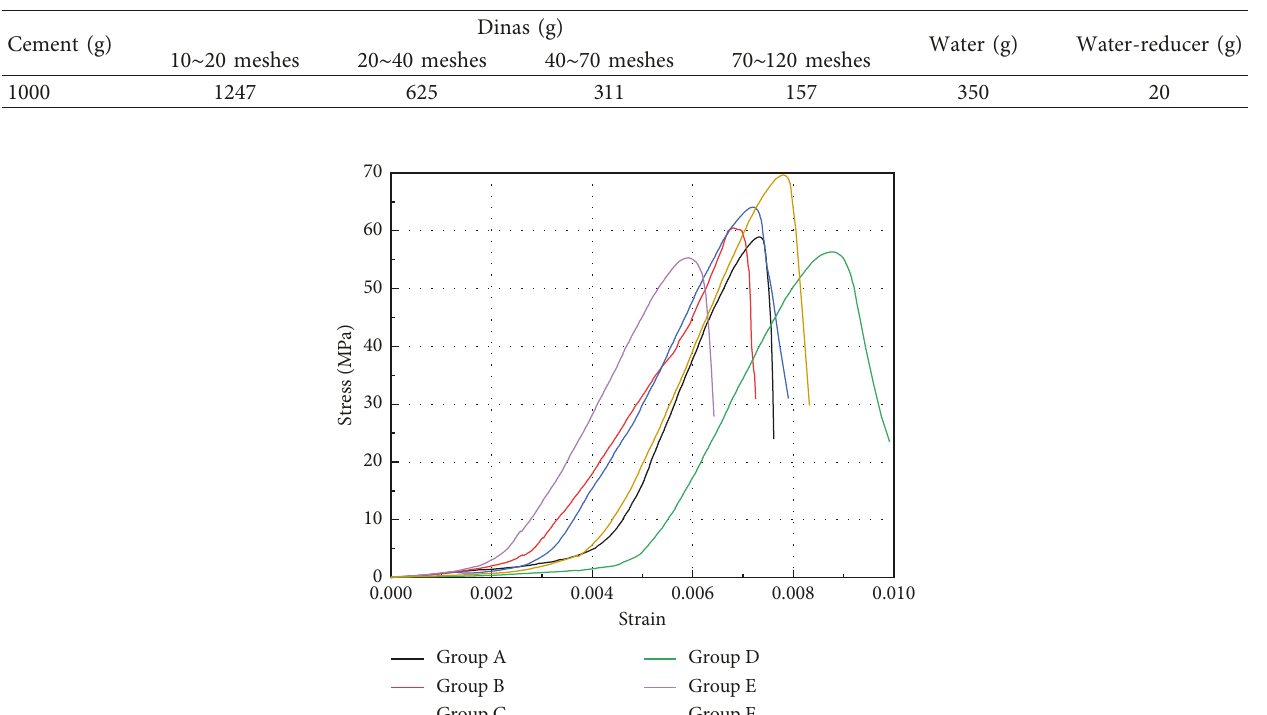
Table 1: Mix proportion of mortar quality.